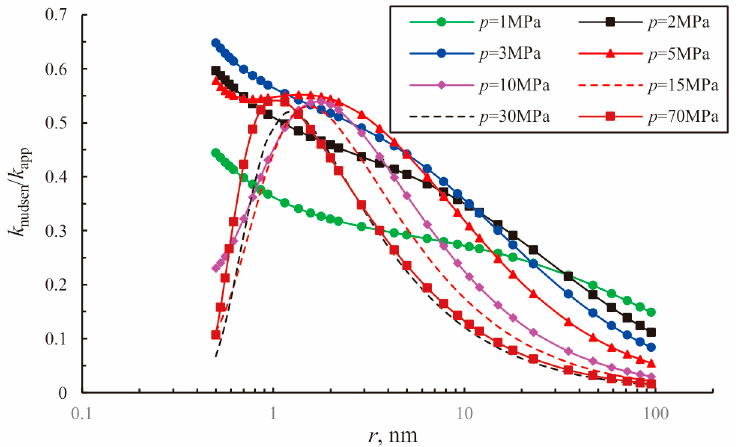
Figure 12. The contribution of Knudsen diffusion to total flux in different conditions.